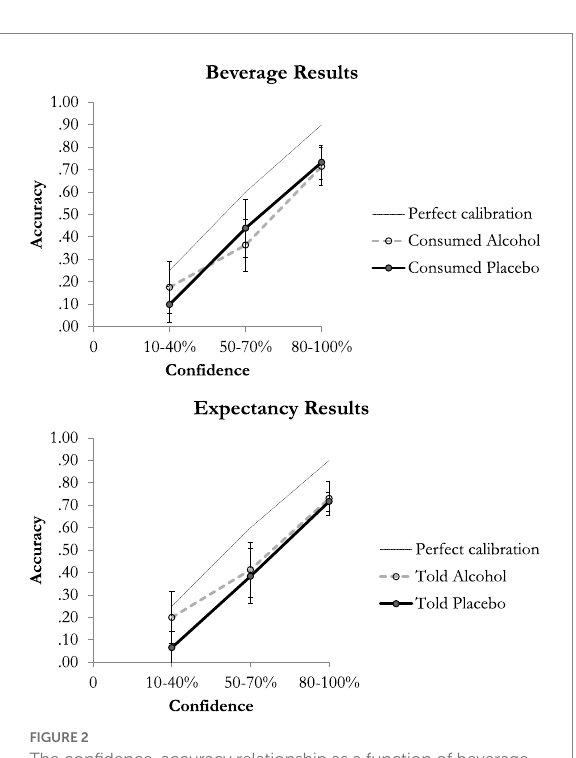
FIGURE 2 The confidence-accuracy relationship as a function of beverage (top panel) and expectancy (bottom panel). Error bars reflect +/- 1